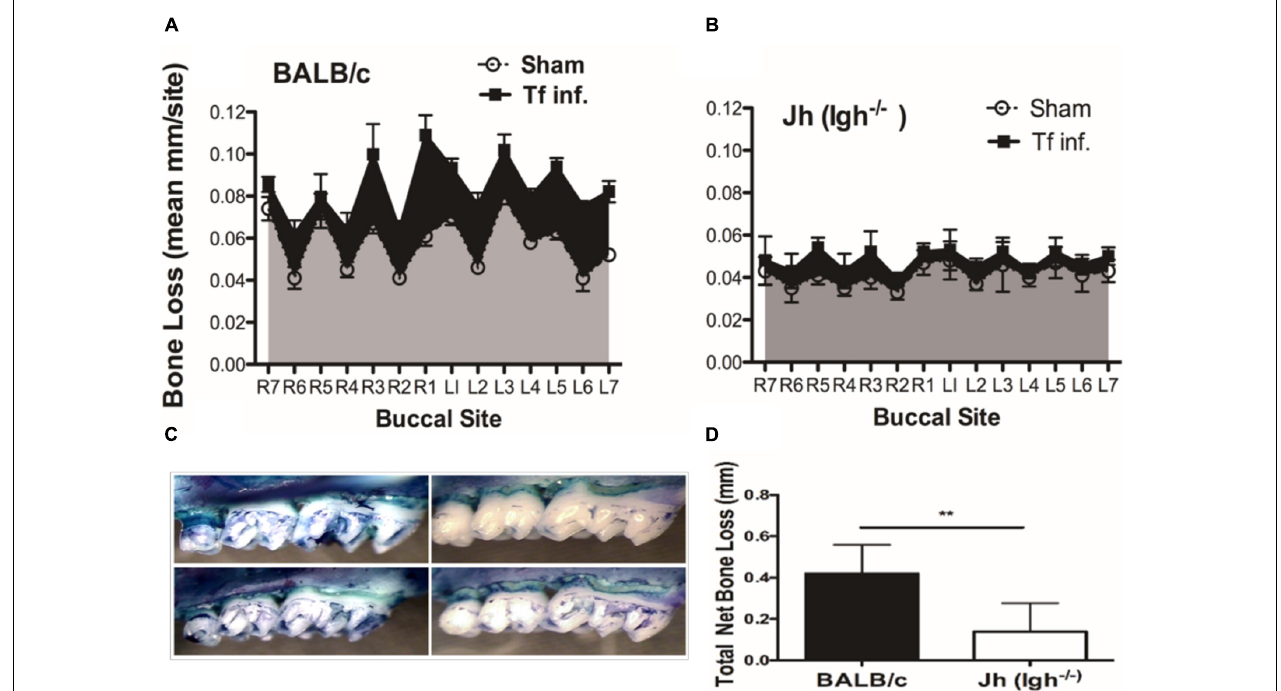
FIGURE 1 | B cell deficiency attenuates pathogen induced alveolar bone loss. Wild type and Jh (Igh − / − ) mice ( n = 8) were infected by oral gavage either with T. forsythia cells (Tf. Inf) mixed in carboxymethyl cellulose (CMC) or CMC alone (Sham). Alveolar bone destruction was assessed after 6 weeks by measuring the distance from the ABC to the CEJ at 14 maxillary buccal sites per mouse (R1 to R7, right jaw; L1 to L7, left jaw). Average alveolar bone loss at 14 buccal sites wild-type (A) and Jh (mature B-cell deficient) mice (B) . (C) Representative images of maxillary jaw bones showing alveolar bone levels at each site measured as distances between ABC to CEJ. (D) Net bone loss calculated as average of total bone loss in T. forsythia infected group—total bone loss in sham group) in wild-type and Jh (Igh − / − ) group. As indicated, the net bone loss in the B cell deficient mice is significantly lower as compared to the wild-type mice. Data show means with standard deviations. Statistically significant differences are indicated with asterisks. p–values less than 0.05 were considered significant. (*** P < 0.001; * P < 0.05).